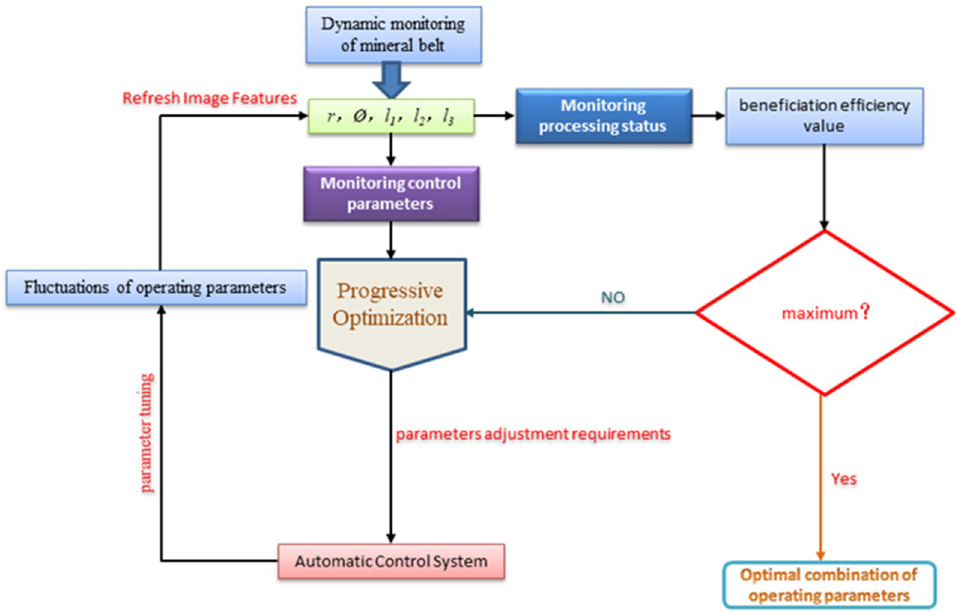
Figure 13. The self-adaptive optimization of control parameters of gravity separation shaking table based on maximization of beneficiation